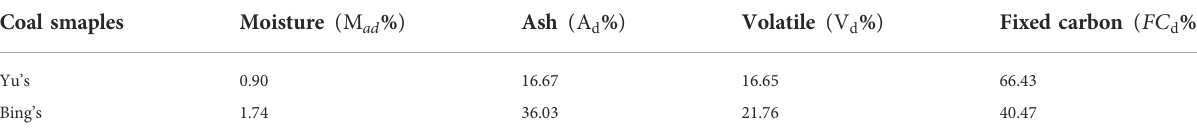
TABLE 1 Coal component test results.